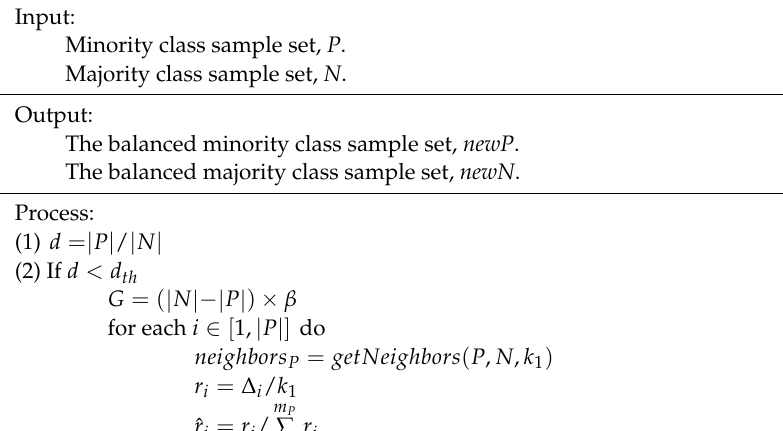
Algorithm 1: Hybrid sampling method combining ADASYN and RENN